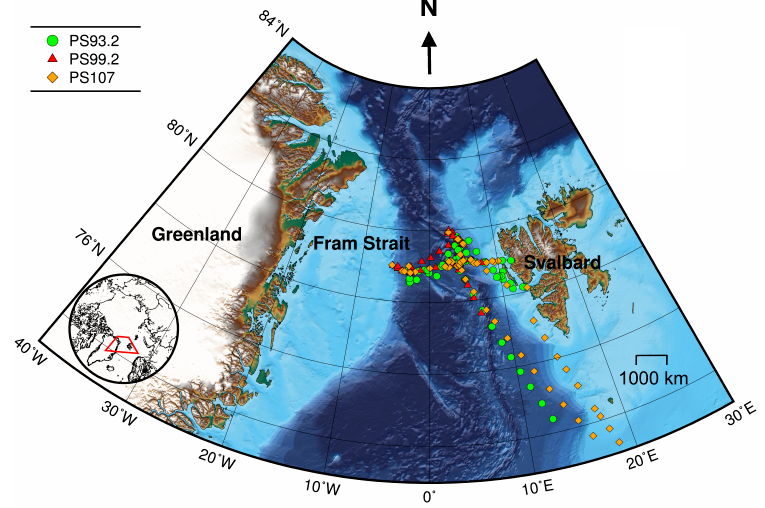
Figure 1. Cruise tracks for PS93.2 (July–August 2015), PS99.2 (June–July 2016) and PS107 (July–August 2017). Symbols denote locations where both AC-S and HPLC data were collected. Bathymetric grid data are extracted from the International Bathymetric Chart of the Arctic Ocean Version 3.0 [62]. Lambert azimuthal equal-area projection was used for